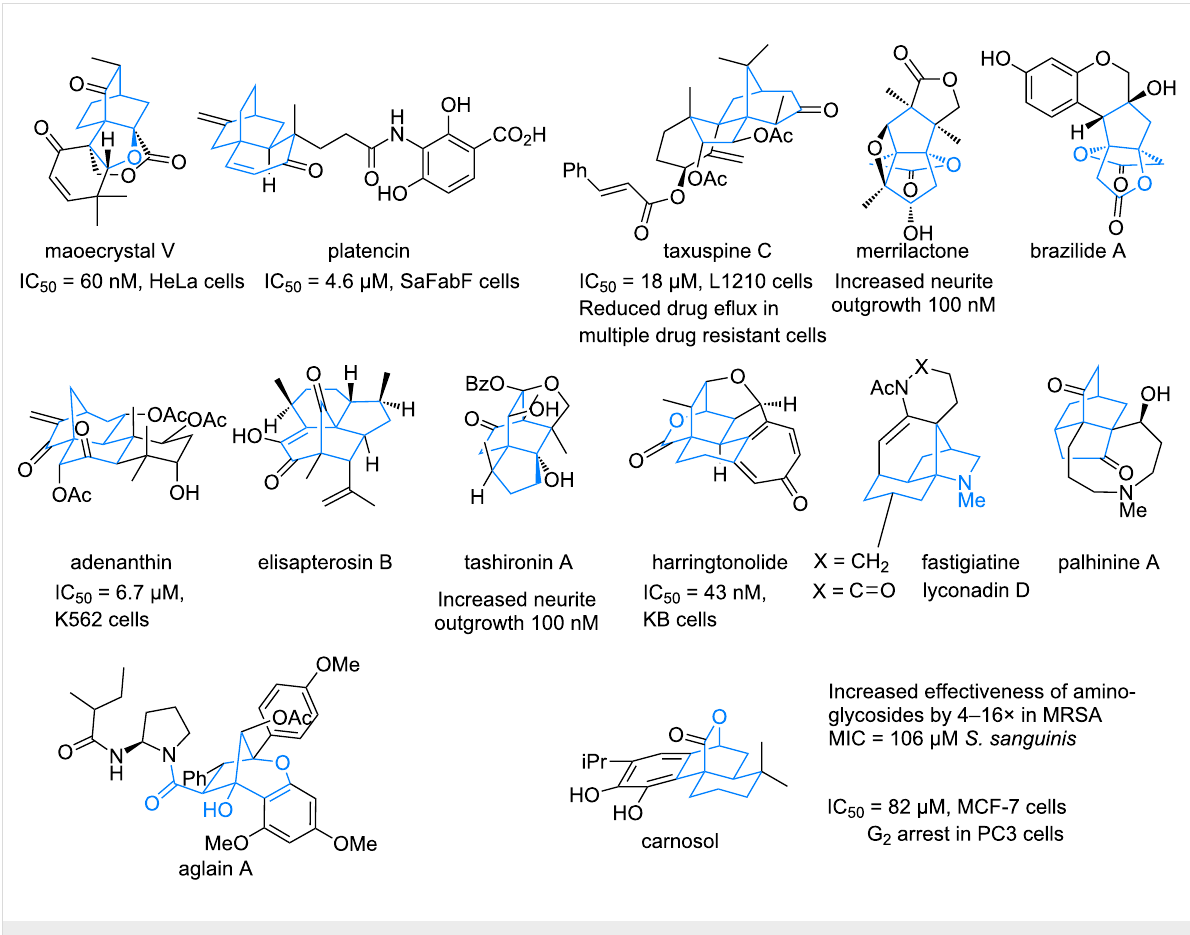
Figure 1: Bridged polycyclic natural products.